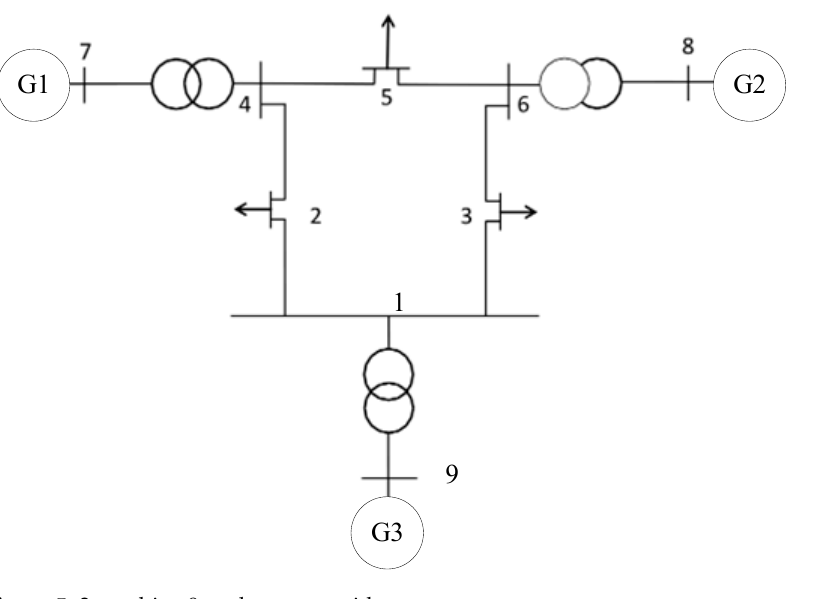
Figure 5. 3 ‐ machine 9 ‐ node power grid. Figure 5. 3-machine 9-node power